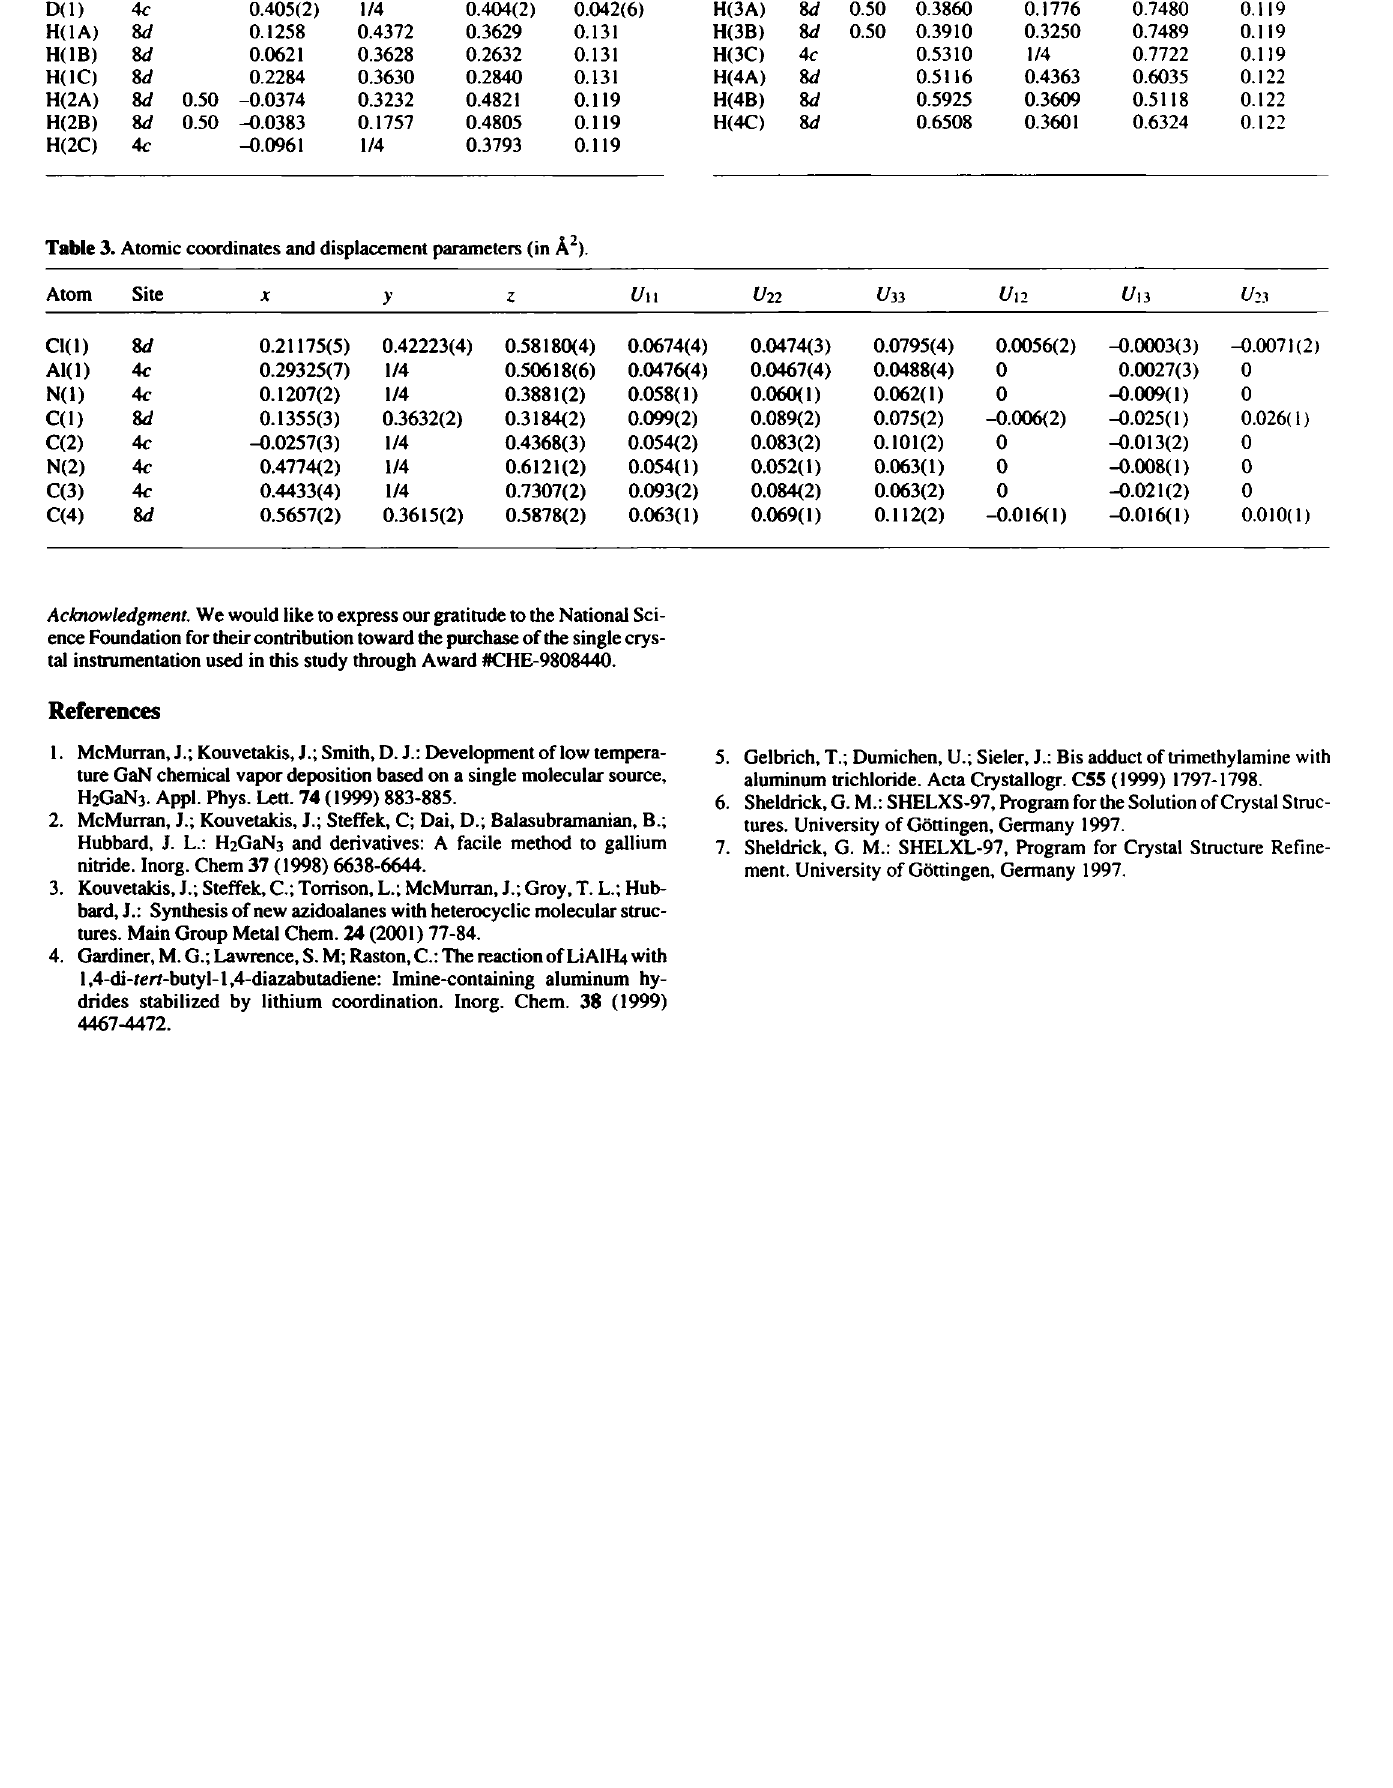
Table 3. Atomic coordinates and displacement parameters (in K 1